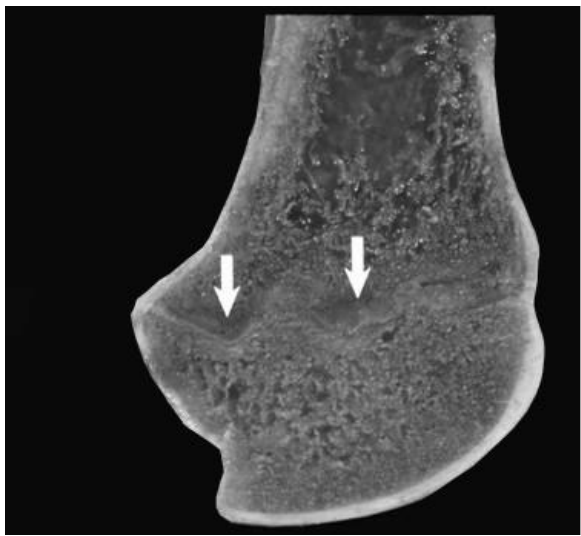
Figure 2. Distal femur from a 1-year-old Qianbei-Pockmarked goat with phosphorus deficiency. White arrows indicate segmental physeal thickening.